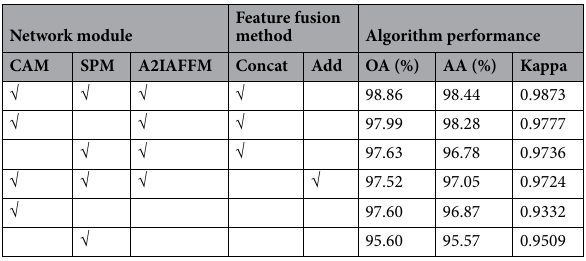
Table 6. Ablation analysis on KSC